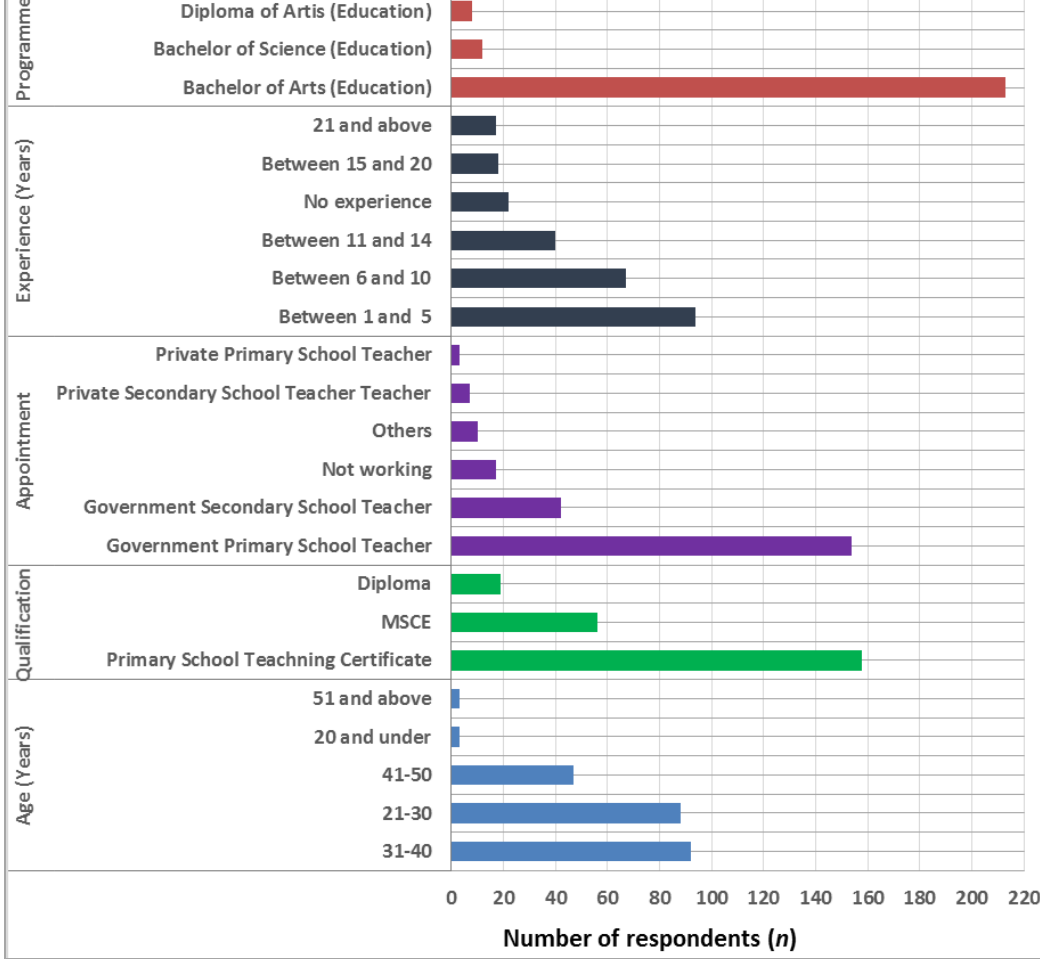
Figure 1 . Background information of students’